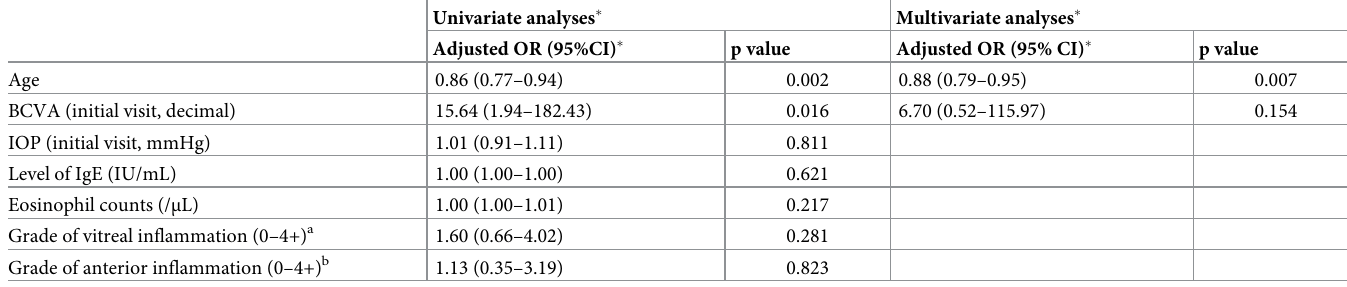
Table 2. Variables associated with the recurrence of OT-related uveitis within 1 year according to logistic regression analyses. Univariate analyses (cid:3) Multivariate analyses